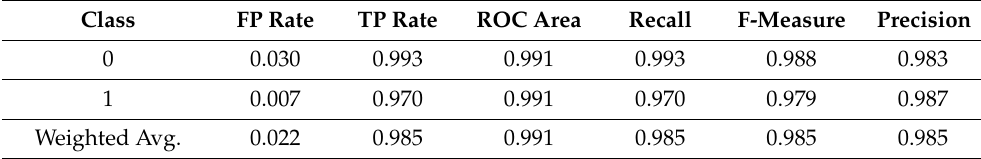
Table 19. Evaluation metrics for Random Forest.